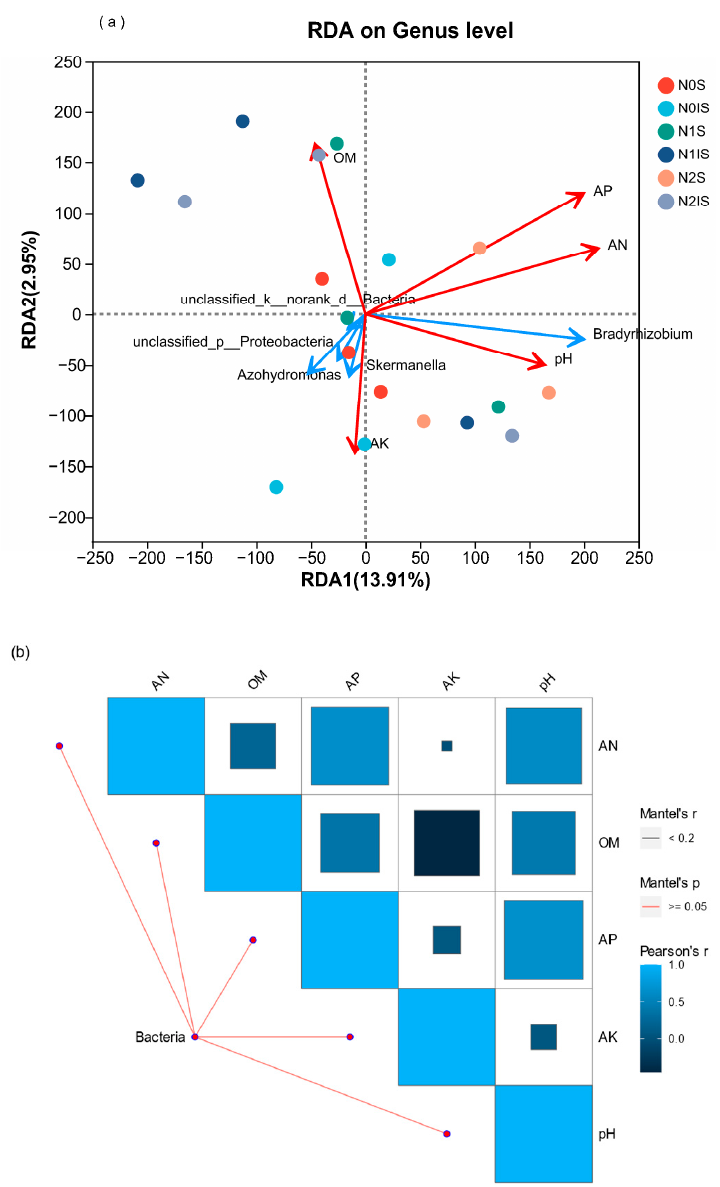
Figure 4. RDA ( a ) and Mantel test ( b ) analysis of soil characteristics of soybean under different nitrogen application levels. Color gradient and size represent Pearson correlation coefficients of physicochemical factors. The edge width represents the Mantel R statistic of the corresponding correlation coefficient, and the color indicates the Mantel p statistic. AN, soil available nitrogen; OM, soil organic matter; TN, soil total nitrogen content; AP; Soil available phosphorus content; AK, soil available potassium.